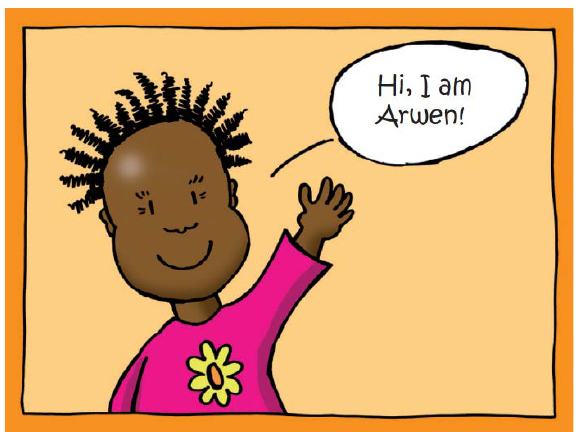
Figure 1. The narration and reception of family history as a personal encounter. The first page of Jarko De Witte van Leeuwen’s Arwen and Her Daddies